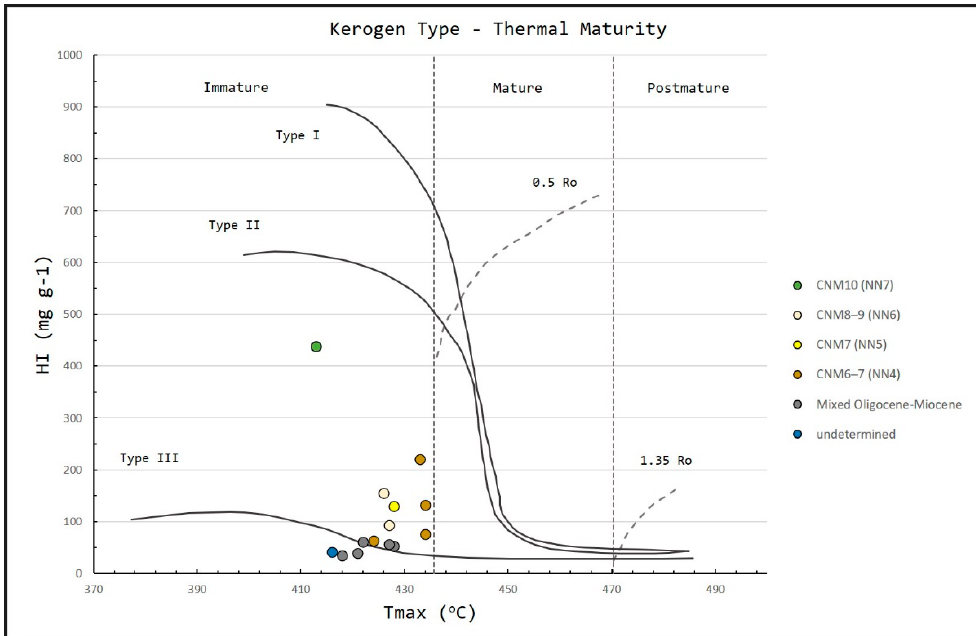
Figure 8. HI vs. Tmax plot showing, in parallel, the kerogen-type curves and maturity levels along with the upper- and lower-vitrinite reflectance thresholds (Ro) for oil generation. Note the distinct position of the sample LEV1GC 4–6 clast 1 (CNM10 biozone), which approaches the type II kerogen curve.